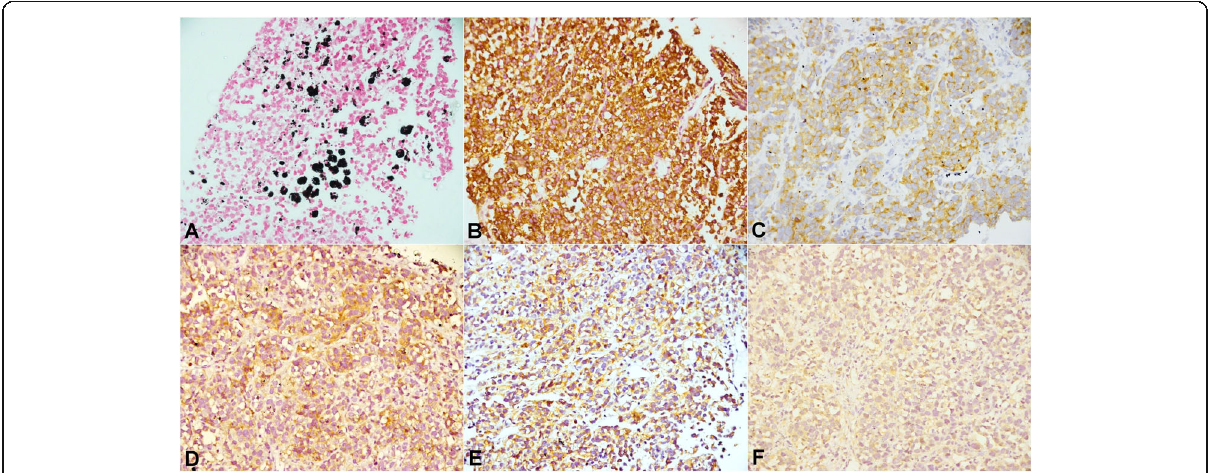
Fig. 3 Histochemical and immunohistochemical findings: Fontana-Masson stain highlighted the black stained melanin granules ( a , FM, ×200). The tumor cells were immunopositive for HMB-45 ( b ), Melan-A ( c ), CD56 ( d ), chromogranin ( e ), and synaptophysin ( f );